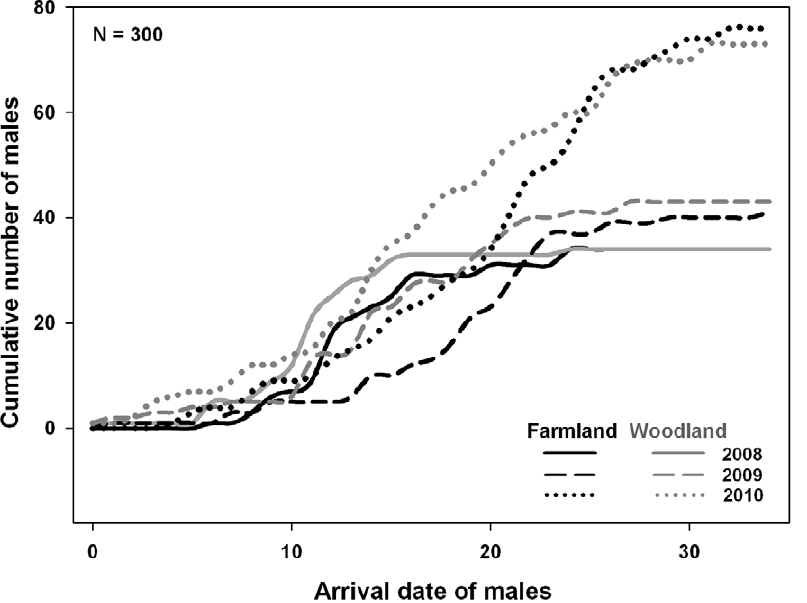
(mm 2 )=size of black eye-stripes in males. Fixed effects: F/W=farmland (F) versus woodland (W) sites, Year=2008, 2009 or 2010 and Study area=1 or 2, Aggregation=number of males settled within a radius of 500 metres. Random effects: territory site